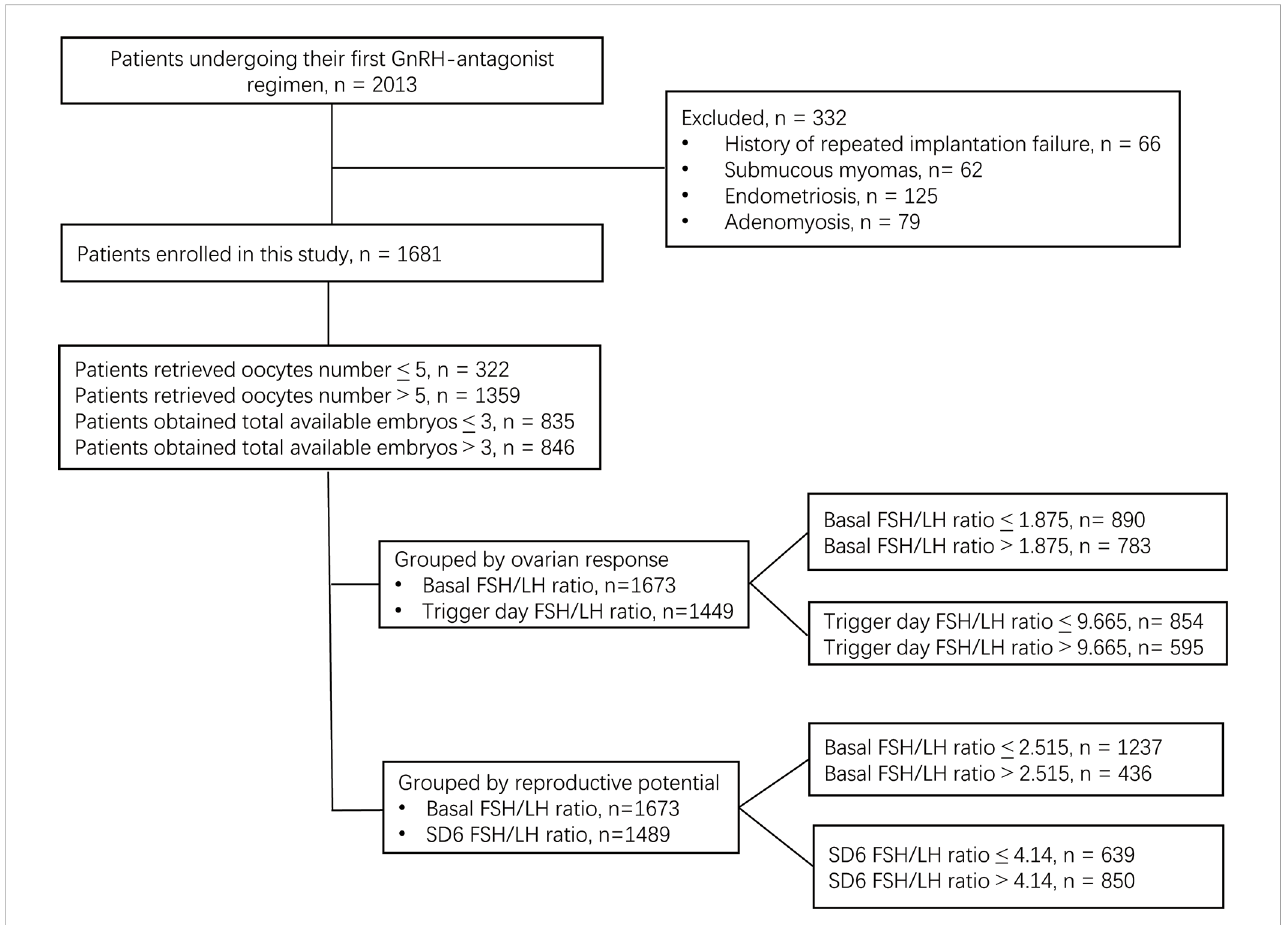
FIGURE 1 Flowchart of this